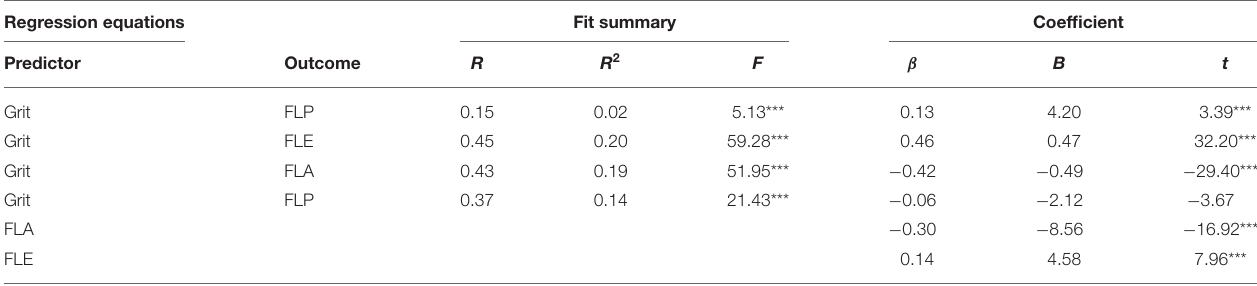
TABLE 5 | Regression analysis results: FLE and FLA as mediators between grit and FLP. Regression equations